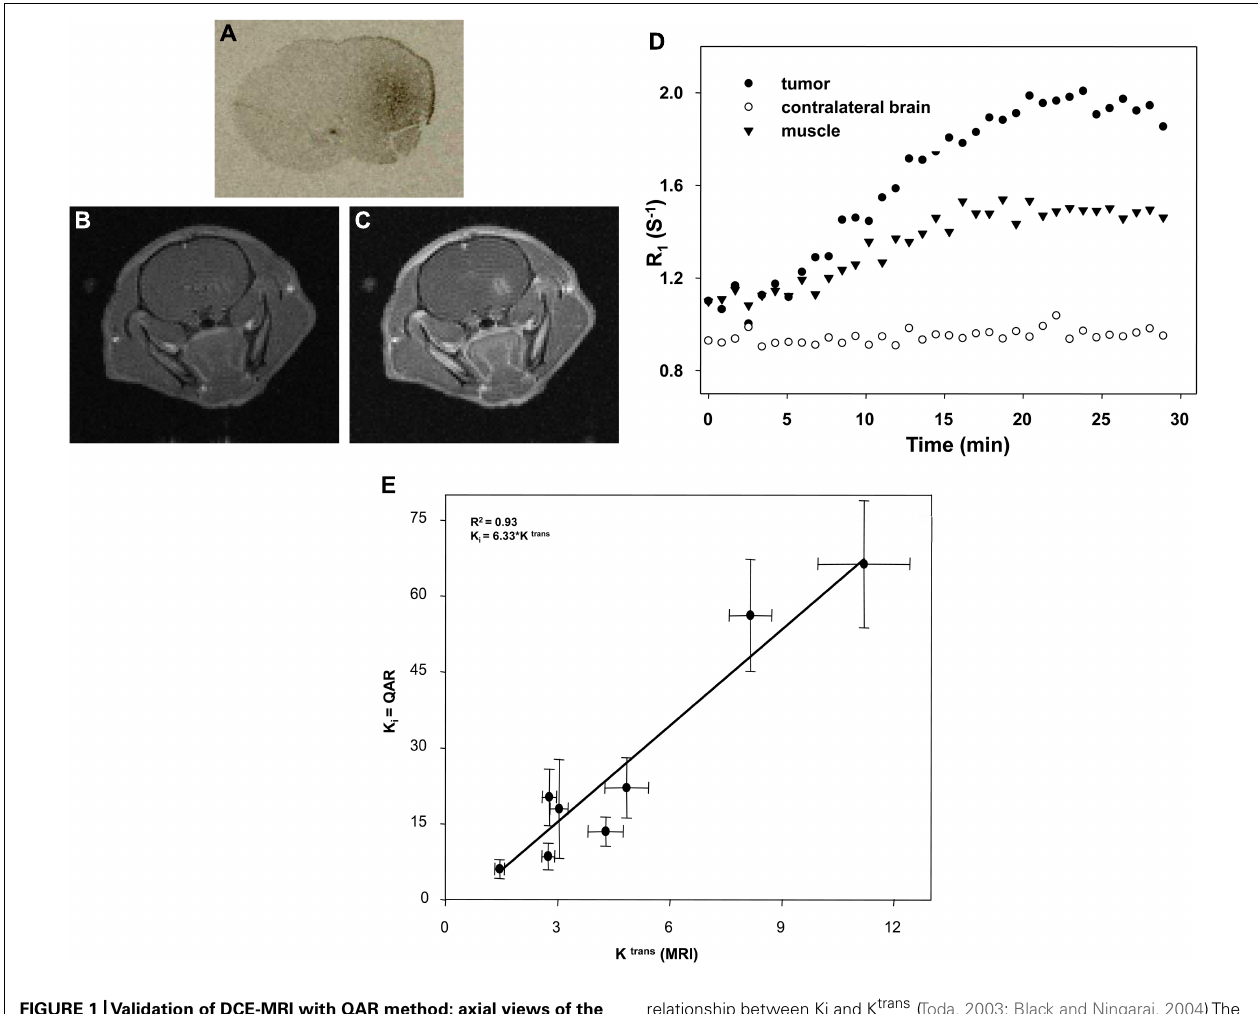
FIGURE 1 |Validation of DCE-MRI with QAR method: axial views of the tumor from a central slice of a rat, QAR image (A), pre-contrast and 10 min post-contrast MR image (B,C). The scatter plot displays the Ki and K trans for the pooled data (D) .The r 2 is 0.93 ( P < 0.05), indicates a significant